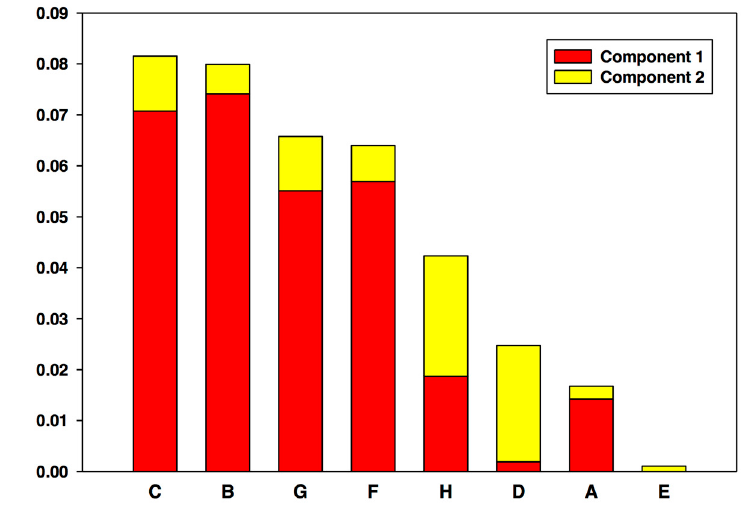
Figure 2. PCA Using Example Data: The PCA algorithm was performed on the example dataset, including data from all times, and was set to include enough components to capture at least 70% variance. Results show that the two low variables exhibiting directional changes (C, B) are the primary drivers, followed closely by the two high variables that exhibit directional change (G, F). The pair of non-linear variables (H, D) is next, followed by the non-changing pair (A, E) ranked last. Note the difference in component distribution between directionally changing and non-linear variables, demonstrating PCA’s ability to separate variables by category.